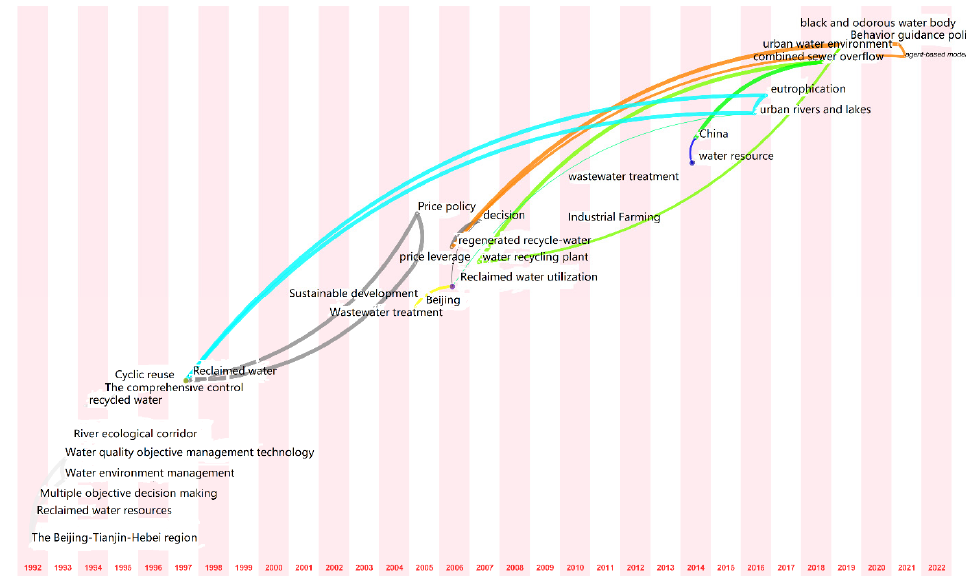
Figure 12. Time-zone map of research on reclaimed water utilization policies from CKNI.